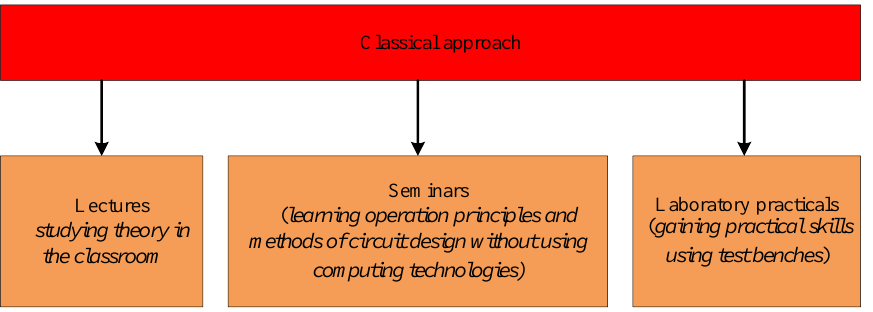
Fig. 1. Classical approach to the distribution of learning material in the